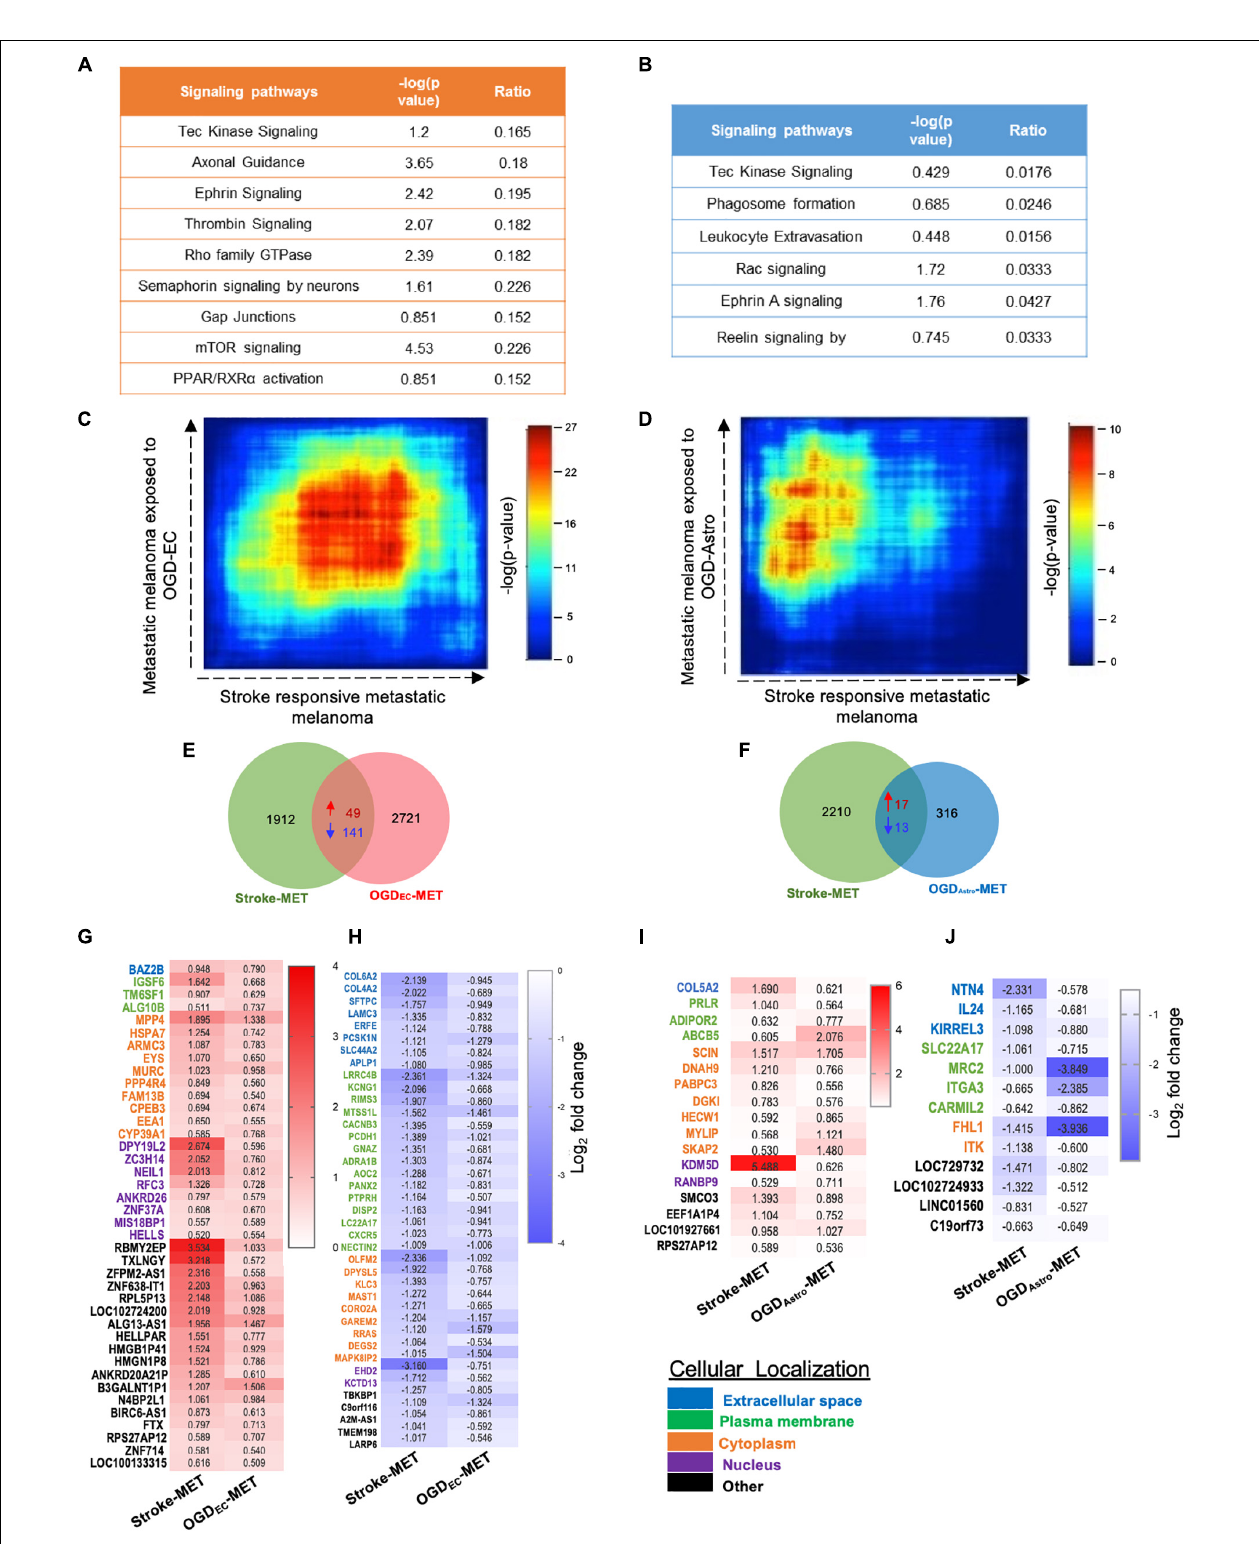
FIGURE 9 | Overlapping transcription landscapes from regenerative NV niche after stroke and melanoma brain metastasis. (A,B) Common canonical signaling pathways between the in vivo Stroke-MET and in vitro OGD- EC MET/OGD- Astro MET transcriptome. (C,D) Rank–rank hypergeometric overlap (RRHO) analysis of common genes expression spread between Stroke-MET and OGD- EC MET/OGD- Astro MET transcriptome. RRHO analysis of common genes expression spread